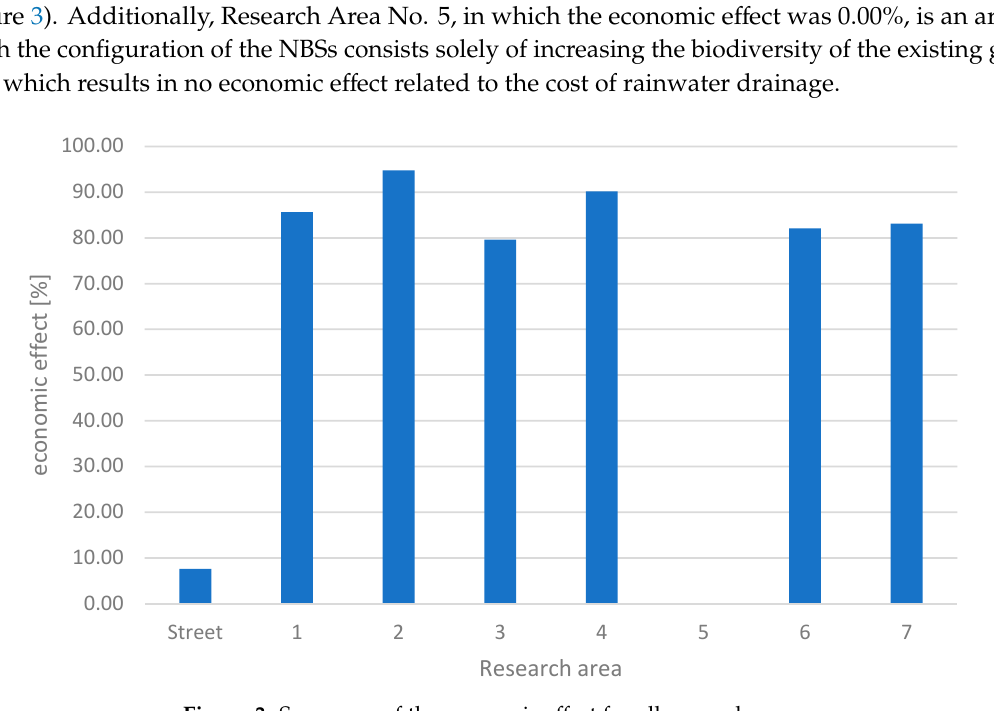
Figure 3. Summary of the economic effect for all research areas.